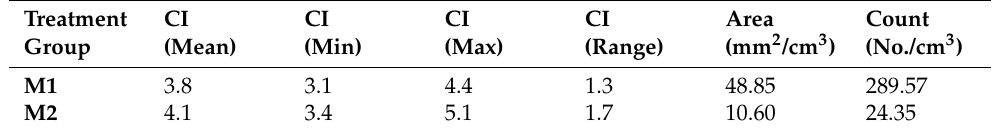
Table 4. Summary statistics of Charring Intensity (CI mean, minimum, maximum, and range) and charcoal concentration (count and area) across the two preparation methods: M1 using water and M2 using dilute bleach.